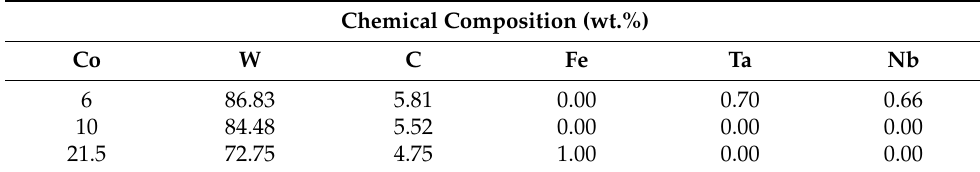
Table 1. Chemical composition of WC-Co according to the Co content.